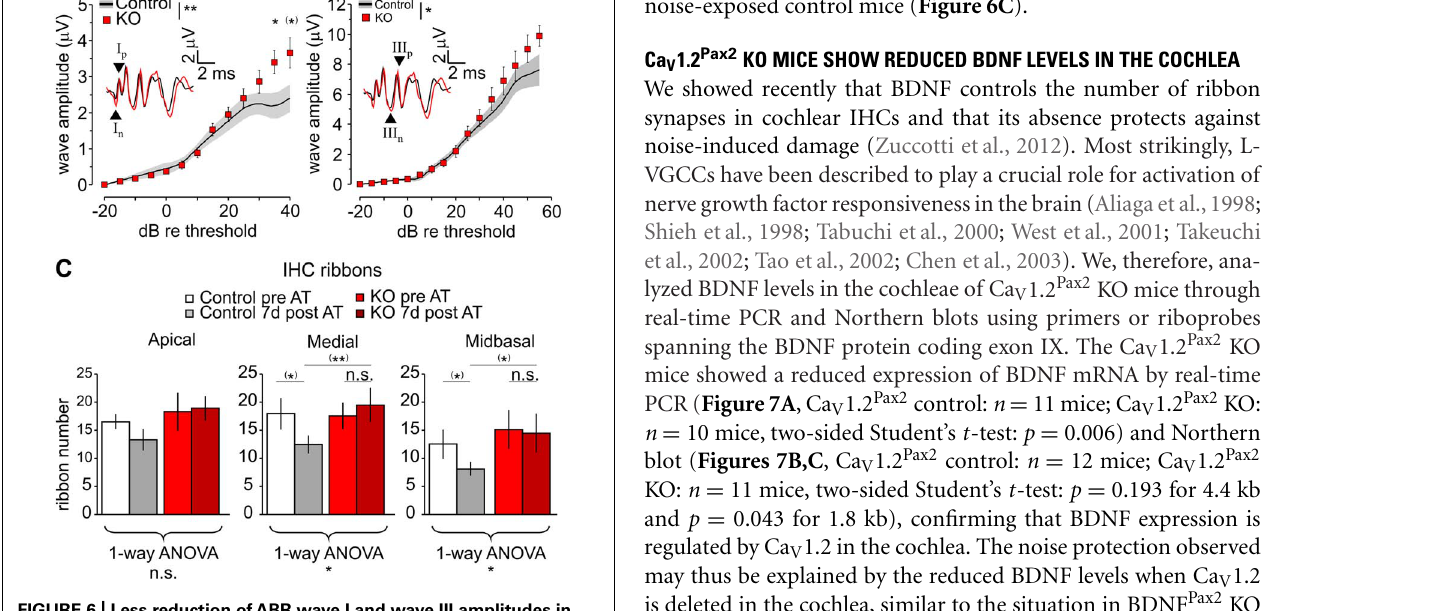
FIGURE 6 | Less reduction ofABR wave I and wave III amplitudes in Ca V 1.2 Pax2 KO mice after noise exposure. (A) Mean ± SEM click-evoked ABR wave I amplitude growth function for Ca V 1.2 Pax2 KO mice (red squares) and controls (control, black line and gray area) 7 days after noise exposure. ABR wave I amplitudes were significantly different (two-way ANOVA, p = 0.004) between KOs ( n = 6–13 ears, 5–8 mice) and controls ( n = 5–11 ears, 5–8 mice), particularly at 35 dB ( post hoc one-sided Student’s t -test: p = 0.038, Bonferroni–Holm’s adjustment for multiple testing) and 40 dB ( post hoc one-sided Student’s t -test: p = 0.026, no Bonferroni–Holm’s adjustment for multiple testing) above threshold.The black and red waveforms in the inset depict ABR traces measured from one individual ear of a Ca V 1.2 Pax2 control and KO mouse, respectively, evoked at the level of 40 dB above the hearing threshold.The leading negative (n) and following positive (p) peak corresponded to wave I are indicated by arrow heads and marked “I n ” and “I p ” respectively. (B) Mean ± SEM click-evoked ABR wave III amplitude growth function for Ca V 1.2 Pax2 KO mice and controls. ABR wave III amplitudes were significantly different (two-way ANOVA, p = 0.013) between KOs ( n = 3–7 ears, 3–4 mice) and controls ( n = 3–10 ears, 3–6 mice).The leading negative (n) and following positive (p) peak corresponded to wave III are indicated by arrow heads and marked “III n ” and “III p ” respectively. (C) Mean ribbon counts ± SD of control and Ca V 1.2 Pax2 KO before and 7 days after noise exposure showing reduction of the number of ribbons between control mice before and after noise exposure at all three cochlear turns, and was statistically significant at the medial and the midbasal turns (one-way ANOVA, apical turn p = 0.060, medial turn p = 0.026, midbasal turn p = 0.047). However, reduction is mainly observed in the control mice (before noise exposure: white bars, n = 4 cochleae, 4 mice; after noise exposure: gray bars, n = 3 cochleae, 3 mice; post hoc two-sided Student’s t -test with no Bonferroni–Holm’s adjustment for multiple testing for medial turn: p = 0.018 and midbasal turn: p = 0.045) but not in the Ca V 1.2 Pax2 KO mice (before noise exposure: red bars, n = 3 cochleae, 3 mice; after noise exposure: dark red bars, n = 3 cochleae, 3 mice; post hoc two-sided Student’s t -test with no Bonferroni–Holm’s adjustment for multiple testing for medial turn: p = 0.306 and midbasal turn: p = 0.773). Seven days after noise exposure, larger number of ribbons are observed in Ca V 1.2 Pax2 KO mice at all three cochlear turns and are significantly larger at the medial turn ( post hoc two-sided Student’s t -test with no Bonferroni–Holm’s adjustment for multiple testing, p = 0.004) and midbasal turn ( post hoc two-sided Student’s t -test with no Bonferroni–Holm’s adjustment for multiple testing, p = 0.023) compared to control